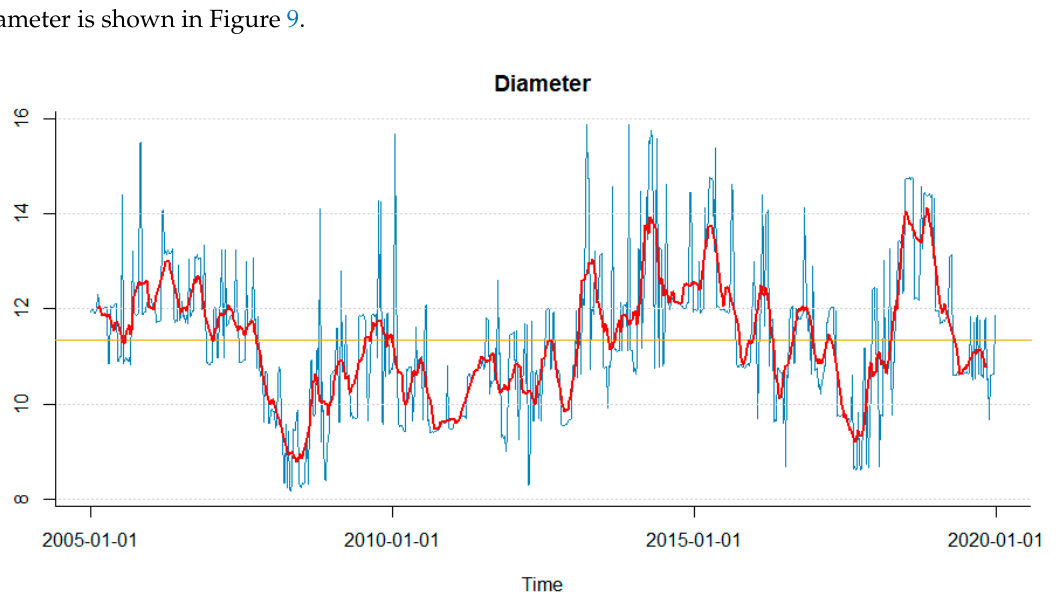
Figure 9. Diameter in the period from 7 January 2005 to 20 December 2019. Red lines depict the 13 periods of the moving average smoothed series. Source: Own study.